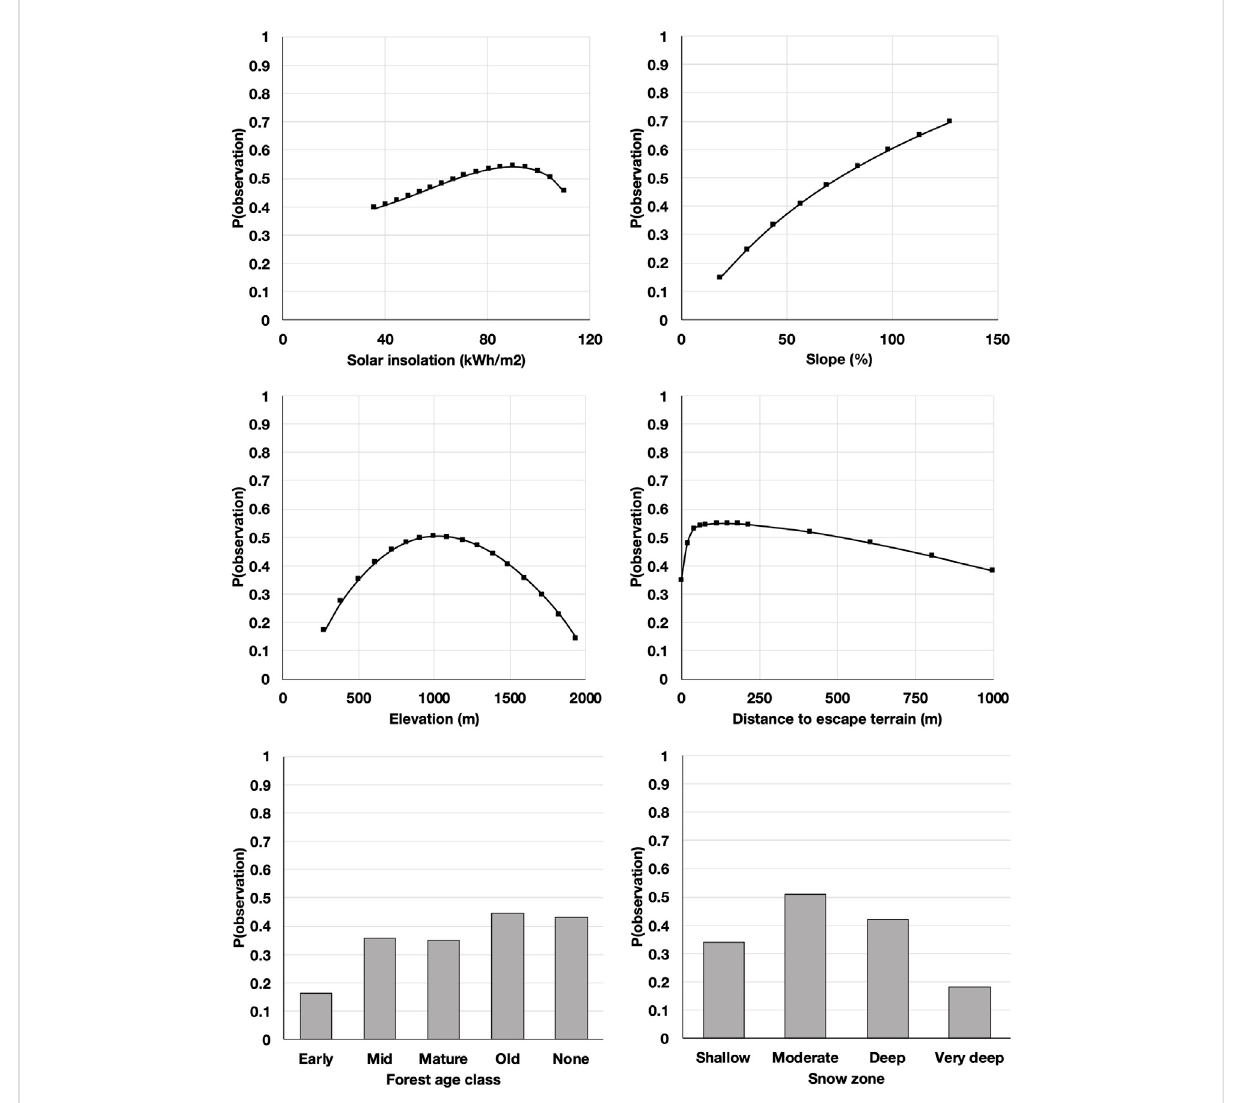
FIGURE 5 Independent(direct) effectsofmodelinput variablesontheprobability ofapointbeingclassi fi edasan observation orarandomlocation, based on soft evidence (Peng et al., 2010). Probabilities above 0.5 indicate habitat selection. Steeper slopes indicate a stronger effect